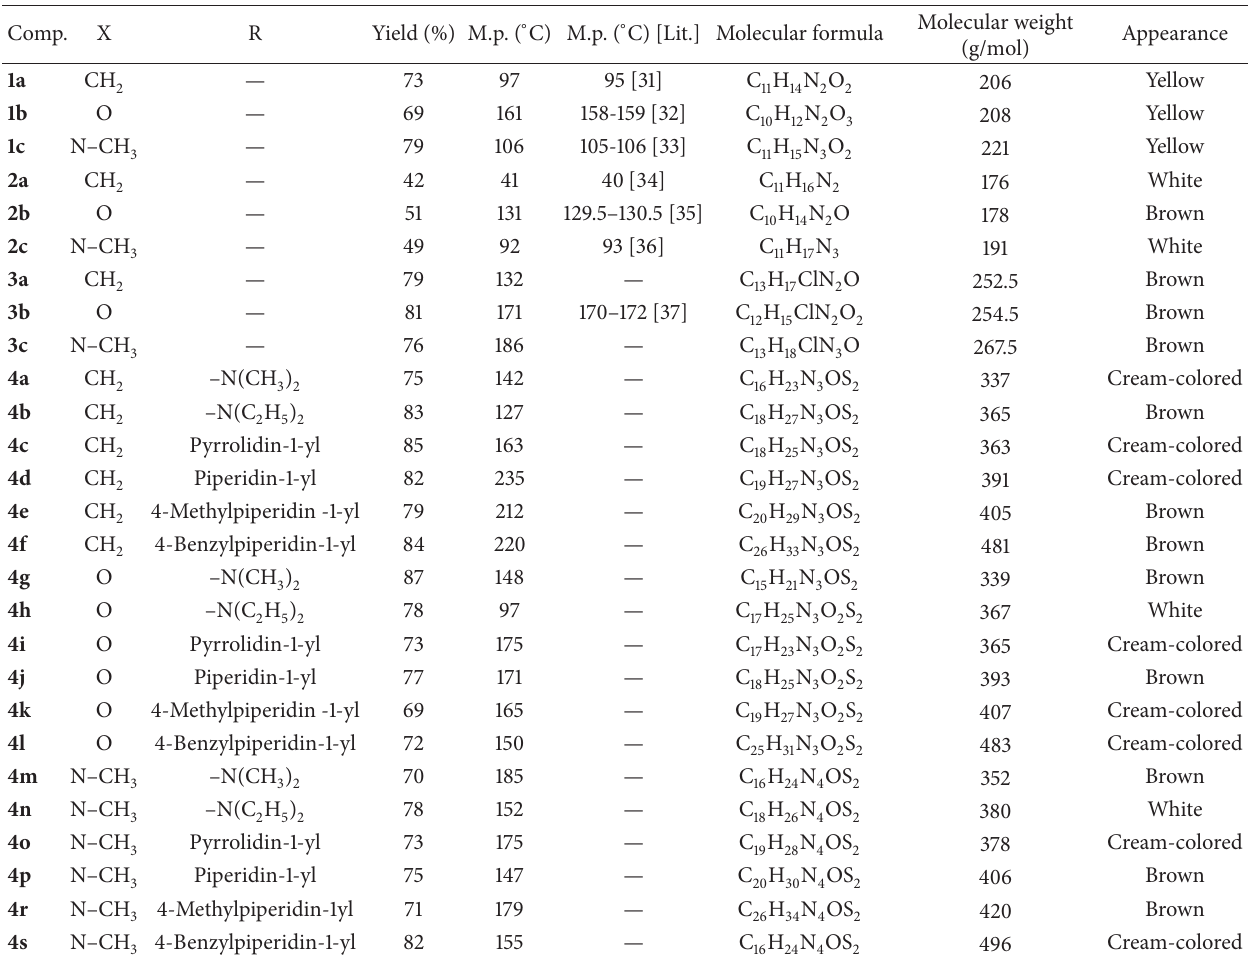
Table 1: Some physicochemical properties of the synthesized